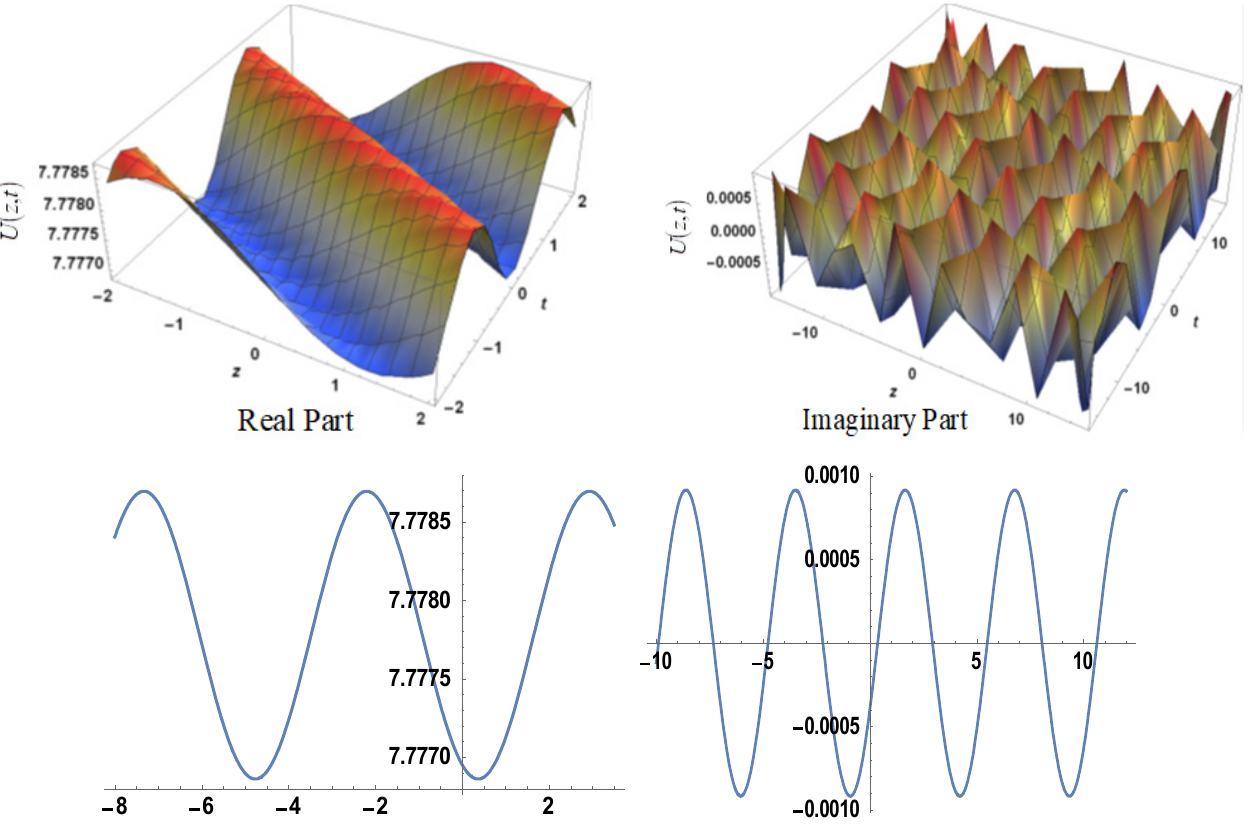
Figure 12. The 3D and 2D plots of Equation (62) for various values of parameters.